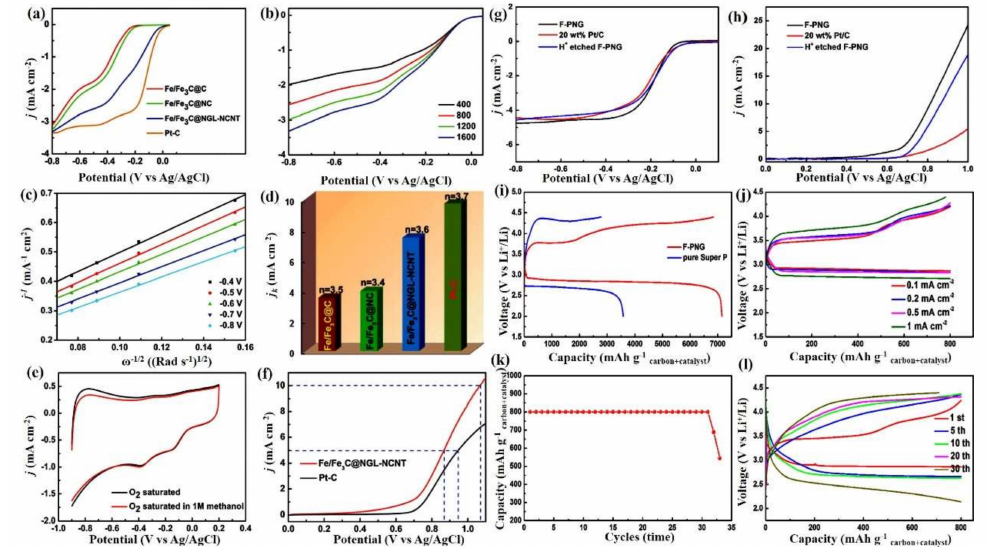
Figure 6. ( a ) Linear sweep voltammogram (LSV) for various Fe3C-Fe-based cathode catalysts at 1600 rpm. ( b , c ) LSV and related K-L curves for an Fe / Fe 3 C@NGL / NCNT electrode. ( d ) Plot of the kinetic limiting current density against electron transfer. ( e ) Cyclic voltammogram (CV) for an Fe / Fe 3 C@NGL / NCNT electrode in O 2 -saturated KOH and O 2 -saturated KOH / methanol solutions (both 0.1 M). ( f ) OER current density for Fe / Fe 3 C@NGL / NCNT and Pt / C electrodes in an O 2 -saturated 0.1 M KOH solution [80]. Copyright 2015 The Royal Society of Chemistry. ( g ) Comparison LSV for the ORR of H + -etched Fe-PNG and saleable Pt / C catalysts at 1600 rpm in a 0.1 M KOH solution saturated with O 2 [83]. ( h ) Comparison LSV for the OER of H + -etched Fe-PNG and commercial Pt / C catalysts at 1600 rpm [83]. ( i , j ) GCD plot for Fe-PNG @ 0.1 mAcm − 2 and various current density rates within a potential window of 2.0–4.4 V. ( k ) Cyclic behavior of an Fe-PNG electrode and ( l ) the corresponding GCD plot at 0.1 mA cm − 2 in a voltage window of 2.0–4.4 V [83]. Copyright 2016